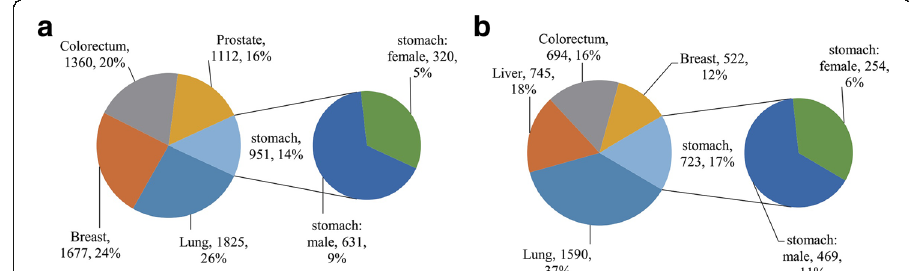
Fig. 2 a Left. Estimated numbers of new cancer cases globally in 2012 (thousands), with the proportions combined for both sexes. Right. The incidence of new cases stratified by sex. The areas represented in the pie charts are proportional to the number of new cases. b Left. Estimated numbers of deaths from cancer globally in 2012 (thousands), with the proportions combined for both sexes. Right. The incidence of death from stomach cancer stratified by sex. The areas represented in the pie charts are proportional to